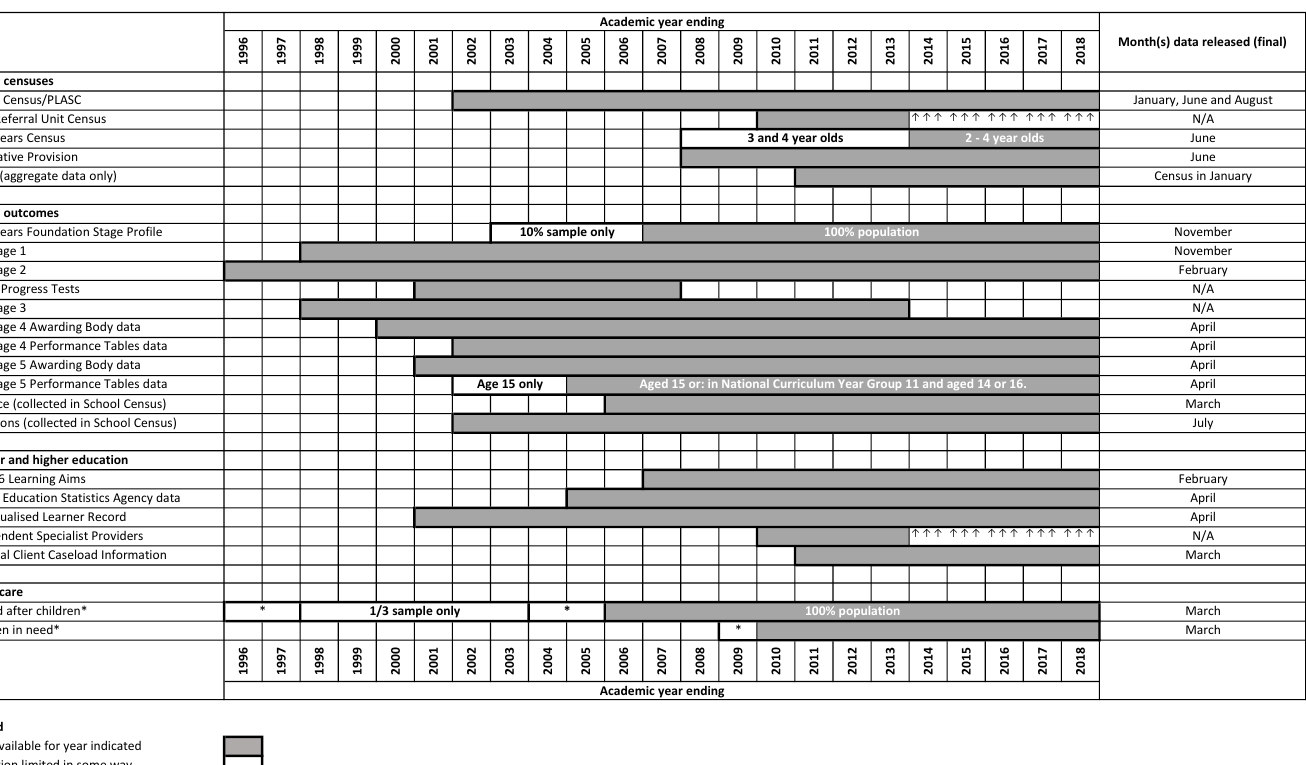
Figure 1: Overview of